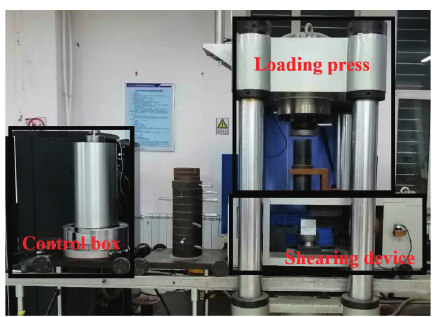
Figure 2: Shearing